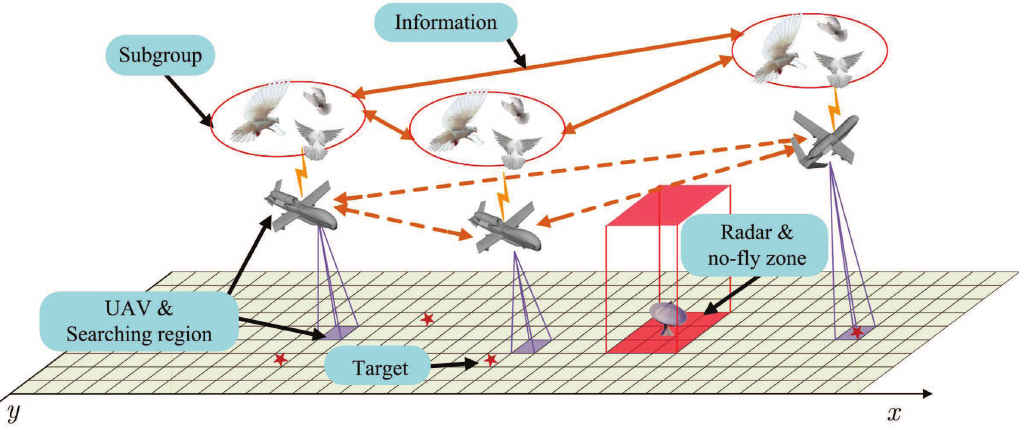
Figure 3. CPIO algorithm for MUCS.